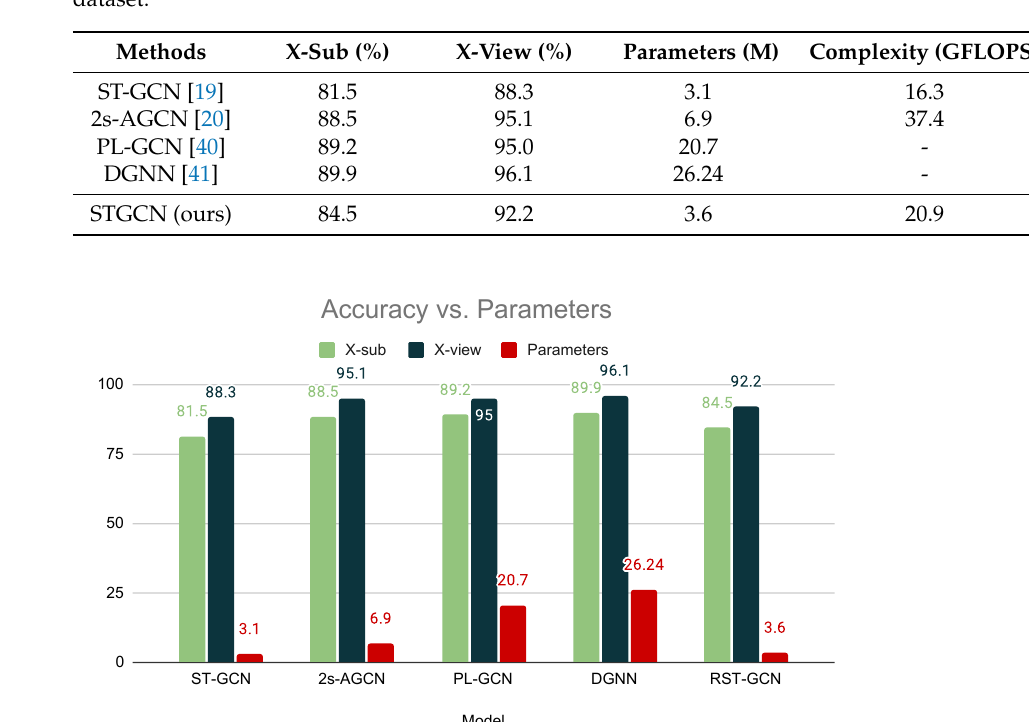
Table 4. Comparisons of STGCN with state-of-the-art GCN-based methods on the NTU-RGBD dataset.